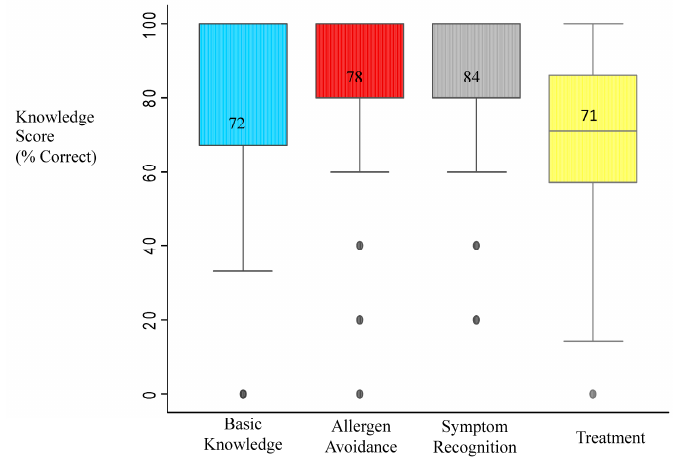
Figure 1. Knowledge scores by content